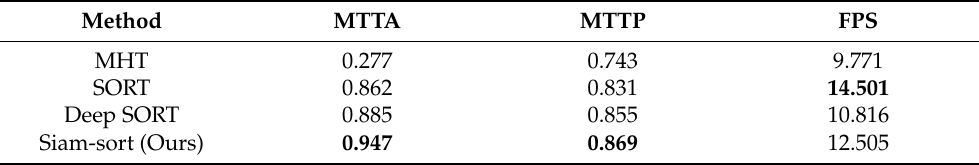
Table 4. The comparative results of four methods on the three overall indicators.